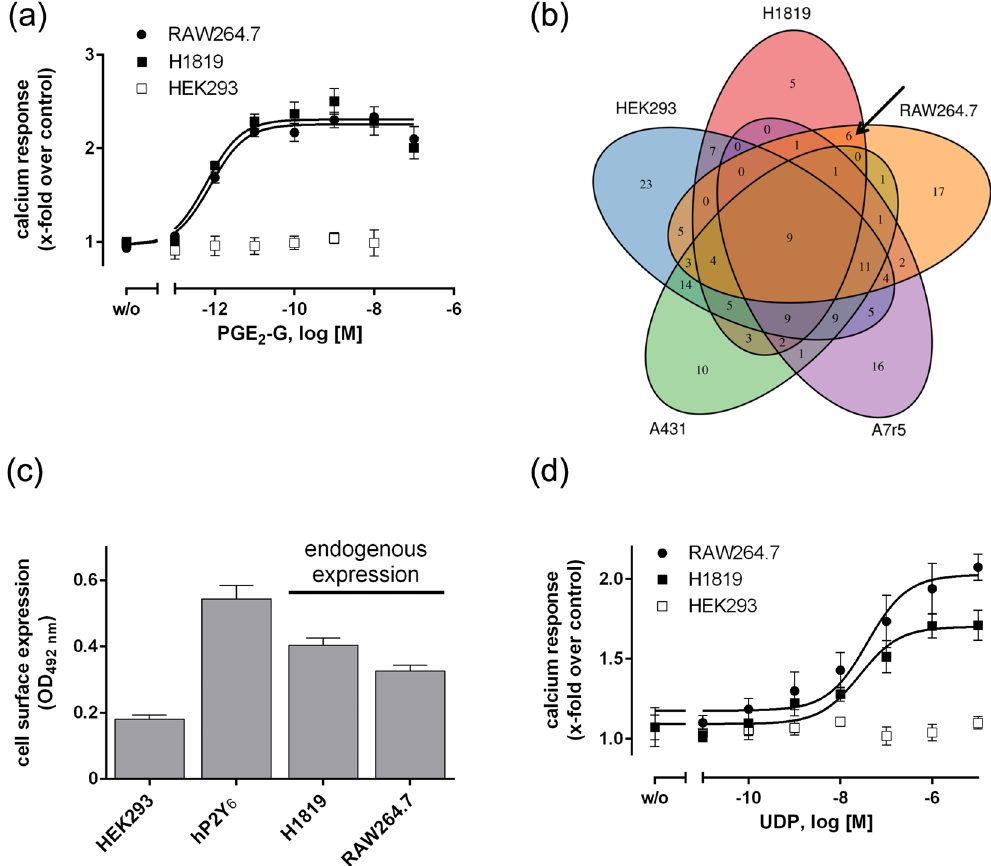
Figure 1. PGE2-G induces intracellular Ca2 + release in different cell lines. ( a ) Different cells lines were treated with the indicated concentrations of PGE 2 -G, and intracellular Ca 2 + measurement was performed as described ( see Methods ). EC 50 values were 0.8 ± 0.1 and 0.7 ± 0.1 pM for RAW264.7 and H1819 cell, respectively. Relative Fluorescence Units (RFU) for control (1% DMSO) were 1,560 ± 479, 2,106 ± 1,193, and 5,247 ± 2,016 for RAW264.7, HEK293, and H1819 cells, respectively. Maximum RFU for PGE 2 -G were 3,649 ± 678, 2,193 ± 252 and 13,143 ± 2,157 for RAW264.7, HEK293, and H1819 cells, respectively. Data are shown as RFU max − RFU min (ligand)/RFU max − RFU min (control). Data are means ± SEM of three experiments, each performed in quadruplicate. ( b ) Expression of GPCRs in the investigated cell lines. The Venn-Diagram shows the number of expressed GPCRs in the investigated cell lines. Numbers in non-overlapping regions correspond to the number of GPCRs specific for the respective cell line, whereas numbers in the overlapping areas correspond to receptors shared by two or more cell lines. 6 GPCRs were exclusively expressed in the two PGE 2 -G-responding cell lines (indicated by arrow). Receptors with an FPKM > 1 were considered to be expressed. ( c ) Endogenous expression levels of P2Y 6 in H1819 and RAW264.7 cells were determined by a cell surface ELISA using an N-terminally directed anti P2Y 6 antibody (see Methods ). HEK293 cells served as negative control and HEK293 cells stably transfected with hP2RY6 as positive control. Protein expression is given as optical density (OD). To determine unspecific antibody binding empty wells were treated similarly and revealed an OD 492 nm of 0.16 ± 0.04. Data are given as means ± SEM of three independent experiments each performed in quadruplicates. ( d ) The effect of UDP on intracellular Ca 2 + release was measured in H1819 and RAW264.7 cells ( see Methods ). Cell lines were incubated with the indicated concentrations of UDP and EC 50 values were 38.4 ± 1.9 and 25.9 ± 2.8 nM for RAW264.7 and H1819 cells,